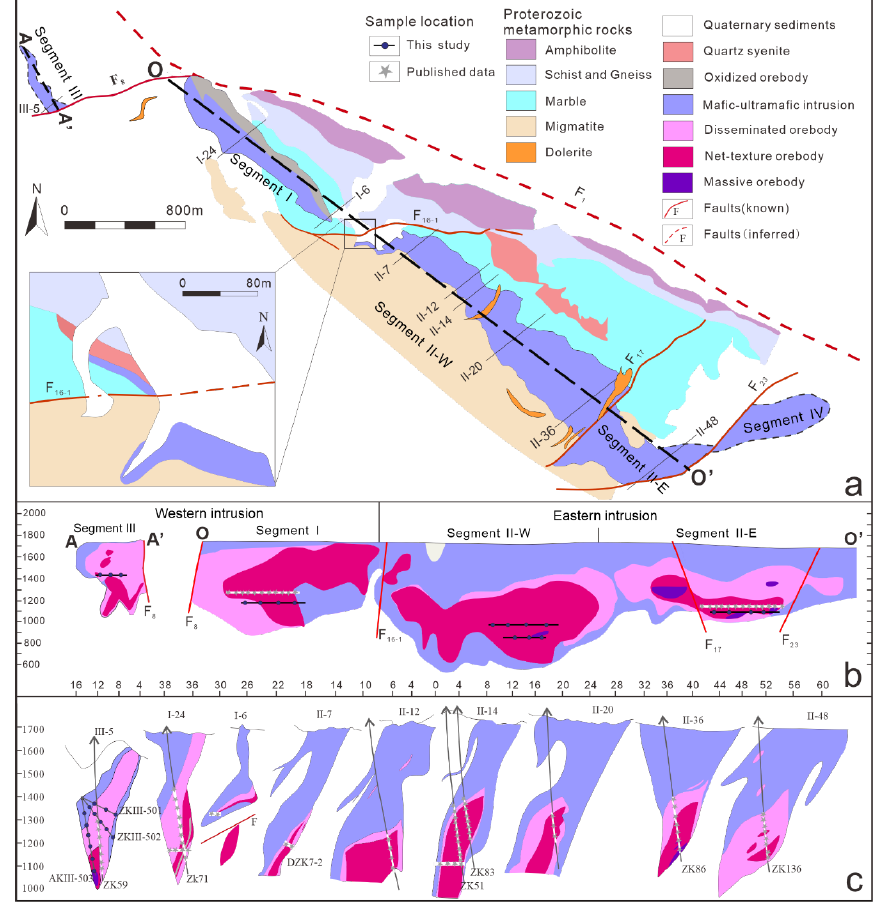
Figure 2. ( a ) Geological map of the Jinchuan deposit (Modified after [23]). ( b ) The projected long section and ( c ) selected the typical cross sections.